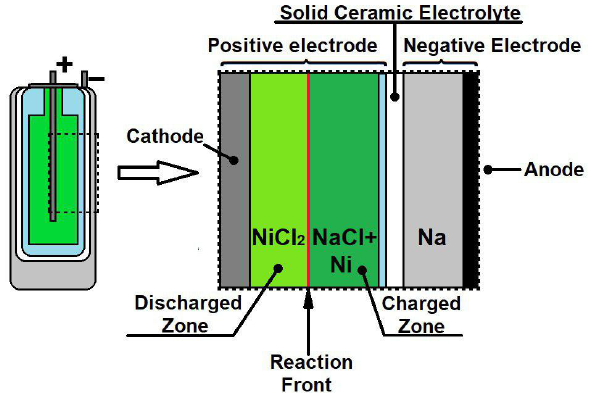
Figure 3. A schematic description of the SMHC during the discharge